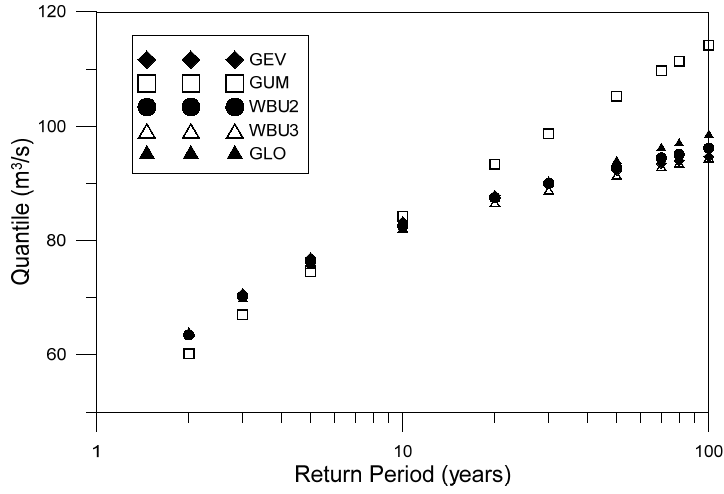
Figure 10. Flood quantiles for the applied probability models.